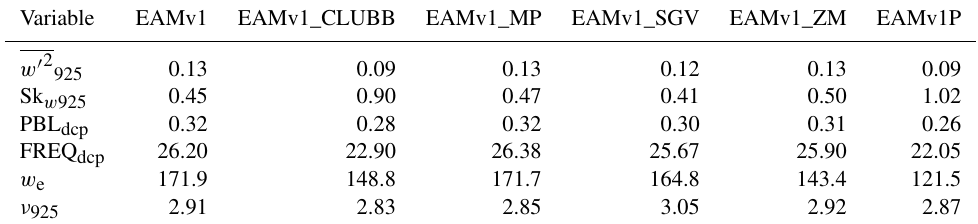
Table 7. Global mean 10-year-averaged PBL properties of EAMv1, EAMv1_CLUBB, EAMv1_MP, EAMv1_SGV, EAMv1_ZM, and EAMv1P. Relevant PBL properties listed here are subgrid vertical velocity variance ( w (cid:48) 2 , unit = m 2 s − 2 ) and the subgrid vertical veloc- ity skewness (Sk w ) at 925hPa, PBL decoupling strength (PBL dcp ; unit = km), PBL decoupling frequency (FREQ dcp ; unit = %), cloud-top entrainment rate ( w e ; unit = md − 1 ), and inverse relative variance of cloud water at 925hPa ( ν 925 ). Only columns with clouds in PBL are